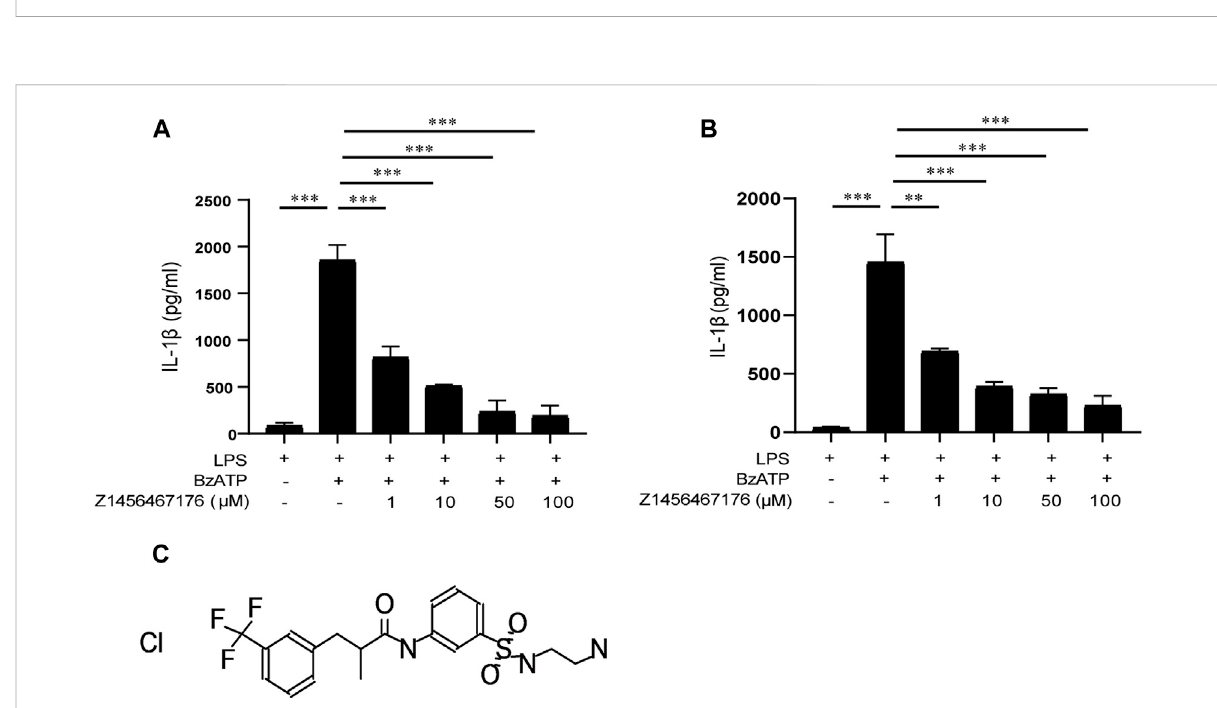
FIGURE. 2 Z1456467176 inhibits BzATP-induced IL-1 β secretion in macrophages. ELISA of IL-1 β in supernatants from LPS (50 ng/ml)-primed THP-1 cells (A) and BMDMs (B) treated with various doses of Z1456467176 (1/10/50/100 μ M) for 30 min and then stimulated with BzATP (100 μ M). (C) Chemical structure of Z1456467176. Data are presented as means ± S.E.M. Statistics were analyzed using Dunnett ’ s t -test. n = 3. ** p < 0.01; *** p <